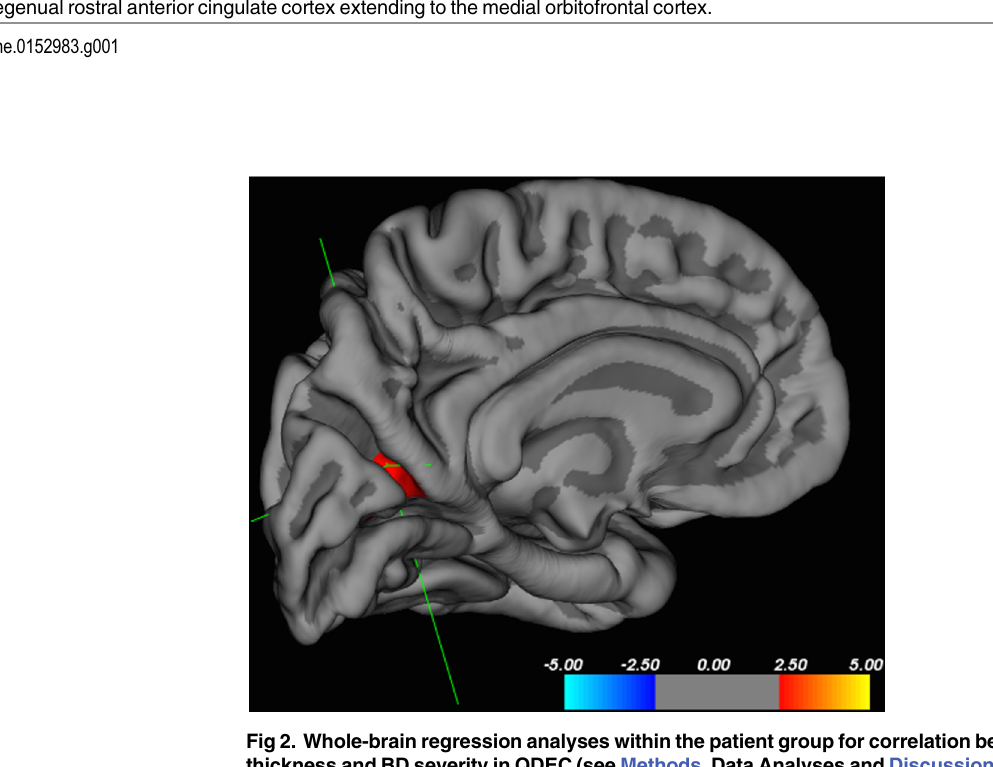
PLOS ONE | DOI:10.1371/journal.pone.0152983 April 6,